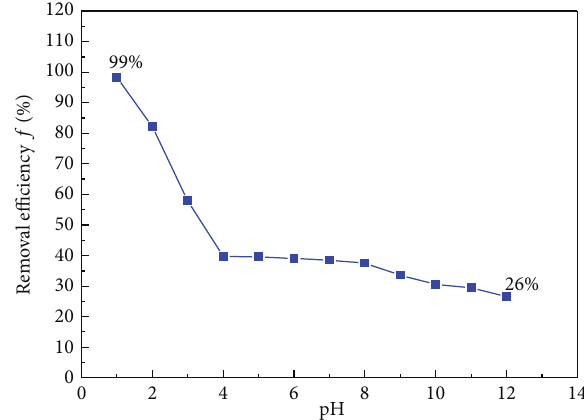
Figure 7: Influence of solution pH on TC removal